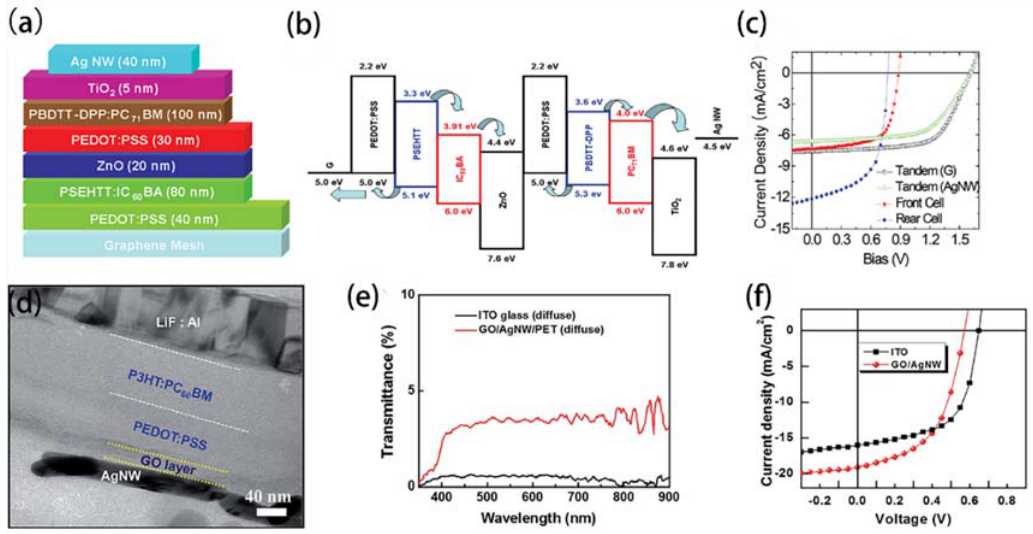
Figure 11. ( a ) The structure of semitransparent tandem cell with graphene mesh anode; ( b ) Proposed energy-level diagram of the semitransparent tandem cell with graphene mesh anode; ( c ) J-V curves of the front, rear, and tandem cells; ( d ) cross- sectional HRTEM image of P3HT:PCBM-based OSCs with GO/AgNW; ( e ) Magnified diffuse transmittance spectra of ITO and GO/AgNW films; ( f ) J-V characteristics of PTB7:PC 70 BM OSCs with the GO/AgNW mesh electrode and the reference device with the ITO electrode. Reprinted with permission form [99,100]. Copyright 2017 The Royal Society of Chemistry and 2014 John Wiley and Sons.